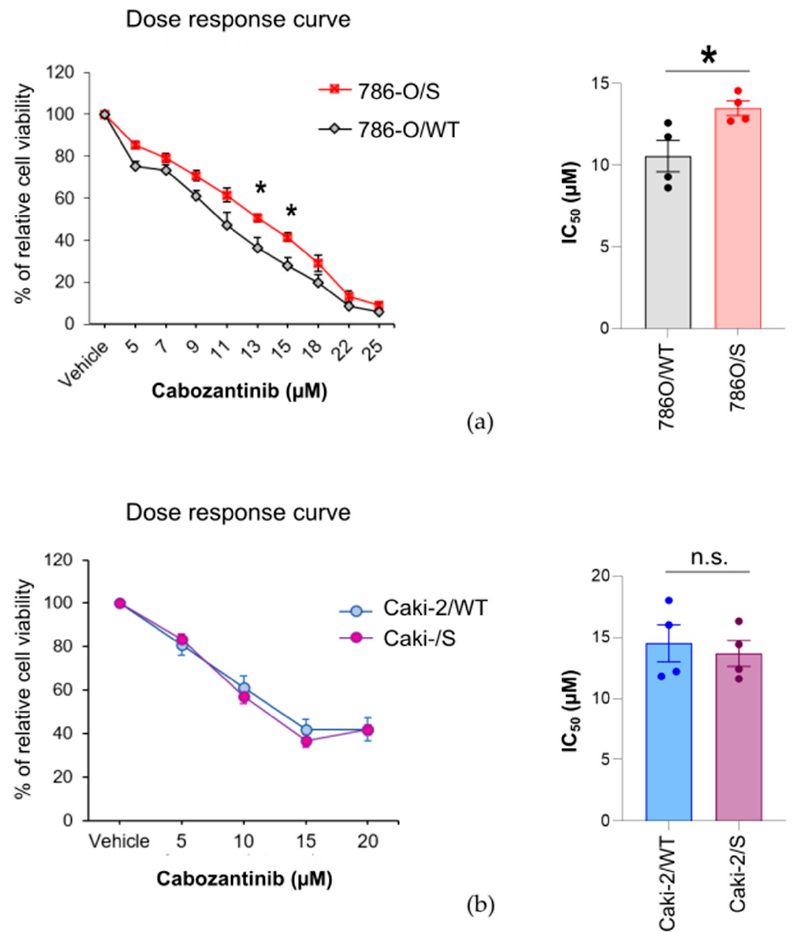
Figure 1. Cytotoxic effect of cabozantinib on human RCC treatment-naïve (wild type) and sunitinib- treated cell lines. Following chronic exposure to sunitinib for 4 months, 786-O/S and Caki-2/S cell lines were subjected to drug withdrawal for 5 days. The paired 786-O/WT and 786-O/S ( a ) and Caki-2/WT and Caki-2/S ( b ) cell lines were treated with increasing concentrations of cabozantinib for 72 h. The number of viable cells was assessed by the WST-1 test. The data are expressed as averages ± SE from independent experiments (n = 4). ( a ) A dose–response curve ( left ) was generated, and the IC 50 values of cabozantinib were compared between the 786-O/WT and 786-O/S cells ( right ). ( b ) Caki-2 cell lines showed an incomplete dose–response curve ( left ), and a negative control value (DMSO) and a positive control cell line (786-O) for a maximally inhibited response were used to constrain the curve and obtain the IC 50 value ( right ). Asterisks (*) indicate significant differences between sunitinib-resistant and wild-type cell lines ( p < 0.05). The figure was generated with Inkscape (version 1.0.2, RRID: SCR_014479).